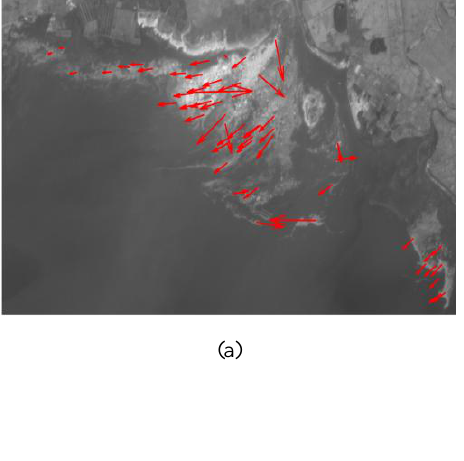
Drifting monitoring of sea ice in Bohai based on MCC, the extraction of feature area rely on artificial interpretation, to extend the time of selection, where the feature is not particularly easy to leak, optional feature area will be too little, and although the accuracy is high, but the sea ice drift displacement field is evacuated. Based on SIFT method, after filtering error points matching, the remaining drift points are too dense, which is not conducive to obtaining the sea ice drift of the whole region.